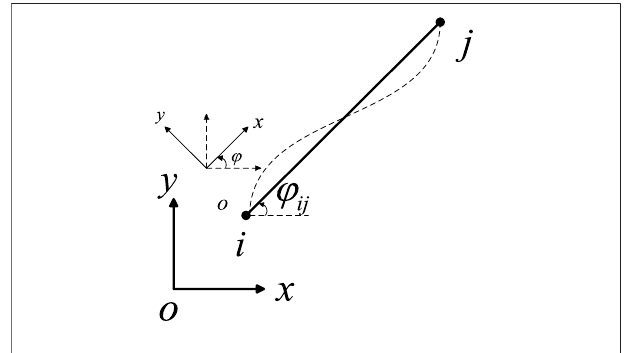
FIGURE2| Globalcoordinatesystemrotationdiagram(point i topoint j